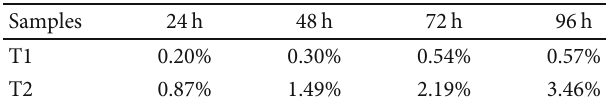
Figure 1: Ripening chart for avocado. Table 1: Weight losses (%) of avocado cv. Hass during storage